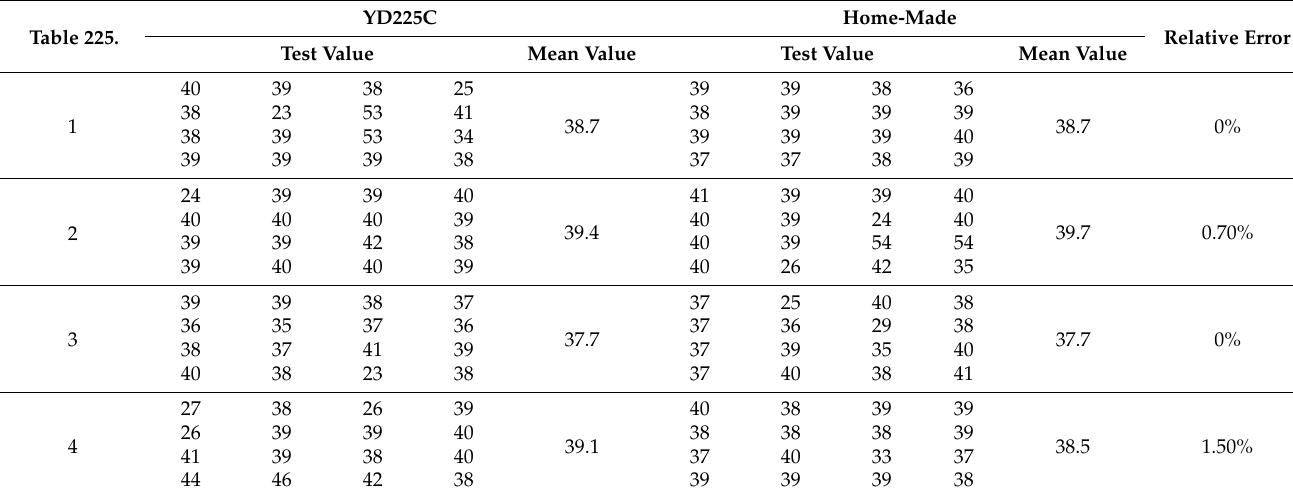
Table 1. Test Results of Four Test